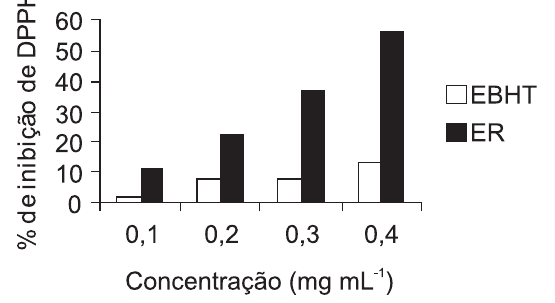
FIGURA 7 - Percentual de inibição de DPPH na EBHT e ER armazenadas à 20 ºC